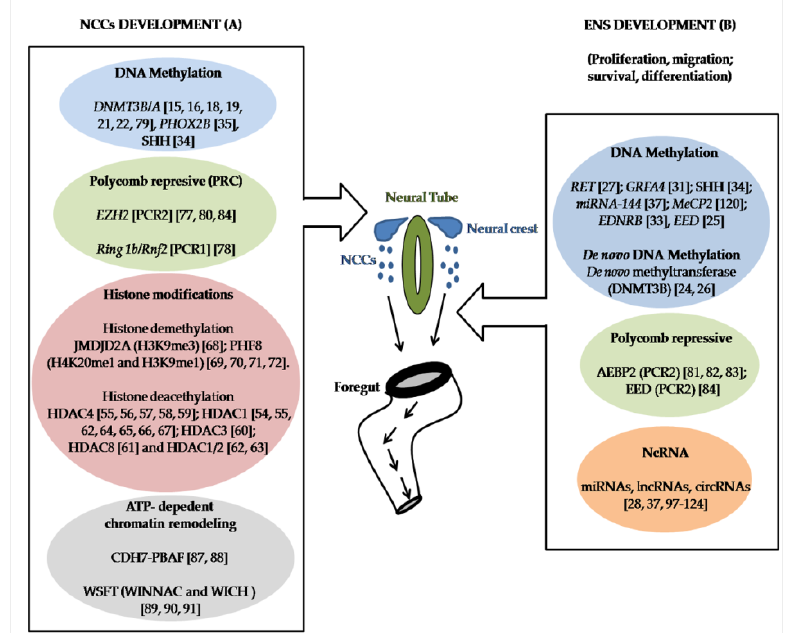
Figure 1. Scheme of the epigenetic processes implicated in Neural Crest Cells (NCCs) and Enteric Nervous System (ENS) development in HSCR context. Epigenetic mechanisms identified in NCC development ( A ) and in ENS formation ( B ) with a possible role in the onset of the disease. Adapted from http://www.columbia.edu/itc/hs/medical/humandev/2006/HD10/ENS6.pdf.